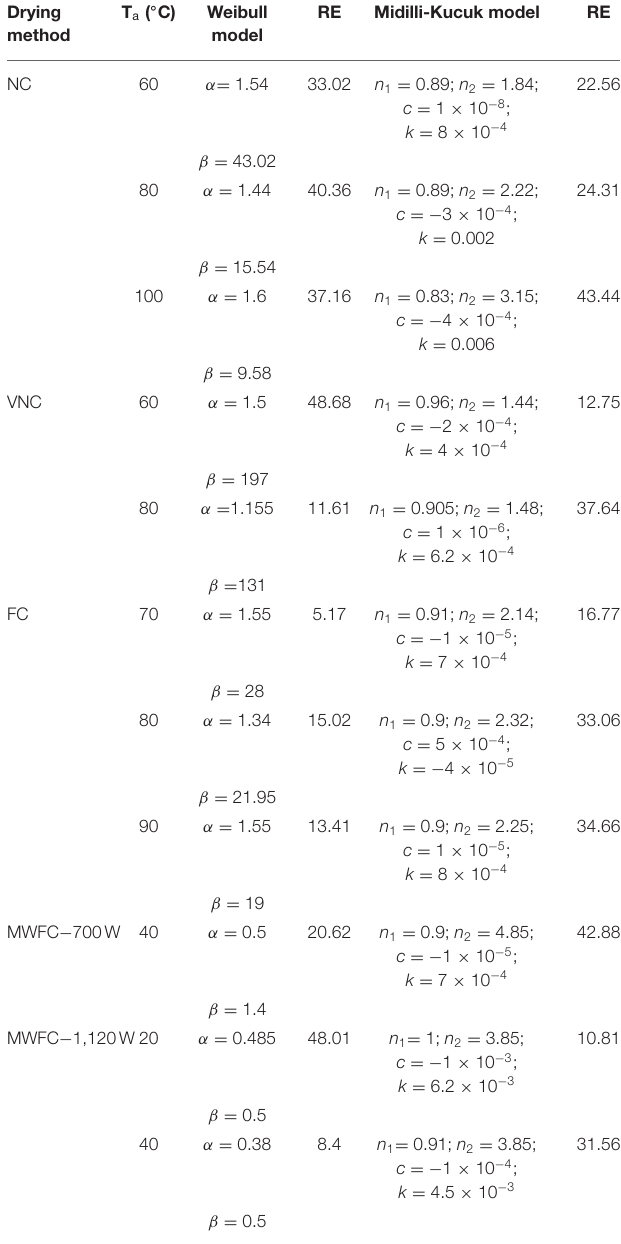
TABLE 2 | Empirical parameter values for each temperature and drying method. Drying